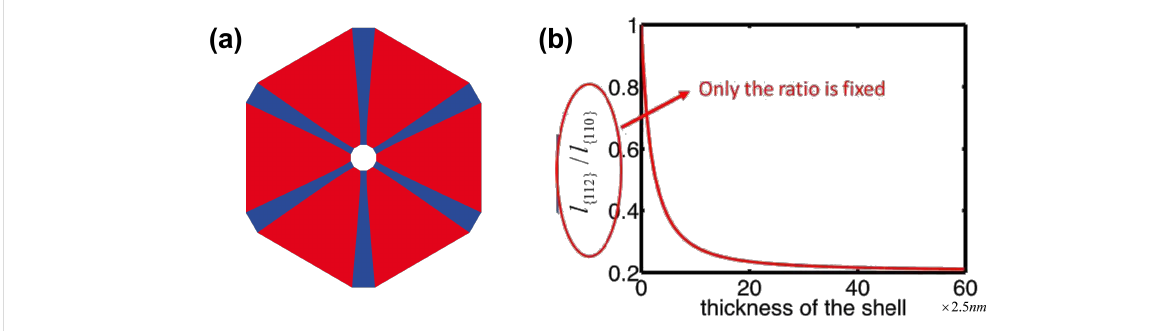
Figure 4: (a) Evolution of a dodecagonal shell to its kinetic Wulff shape due to surface diffusion and deposition. (red: six {110} facets; blue: six {112} facets.) (b) Evolution of the ratio between the lengths of the facets shown in (a).